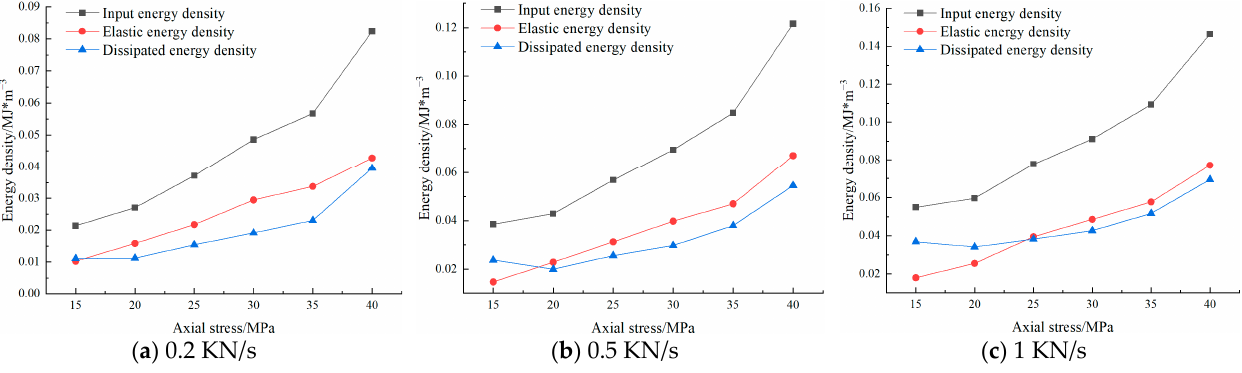
Figure 6. Rock energy evolution curve under different loading rates. Rocks exhibit different forms of damage at different loading rates. In essence, the different stress states determine how the rock energy is distributed and transformed. At the same time, the difference in energy state drives the different deformation and damage modes of the rock. It can be seen that the ratio of elastic energy and dissipative energy-to-input energy affects the damage mode of the rock. Figure 7 shows when the loading rate is 0.5 KN/s. The variation of elastic energy ratio and dissipation energy ratio with axial stress of the rock. From the figure, it can be seen that the elastic energy ratio and dissipation energy ratio vary nonlinearly with the axial stress. The elastic energy ratio increases at the beginning of loading, and then increases when the loading reaches about 48% of the peak stress; it reaches the maximum when the axial stress is loaded to about 73% of the peak stress. The dissipation energy ratio exceeds the elastic energy ratio at the early stage of loading. This shows that the closed friction of microcracks and dislocation between rock blocks dissipate a lot of energy in the compaction stage, thus resulting in the proportion of dissipated energy greater than the proportion of elastic energy. As the loading continues, the dissipated energy ratio gradually decreases. From the initial loading to the loading of about 73% of the peak stress, the dissipation energy ratio decreases by about 30%. After that, the dissipative energy ratio increases. With the continuous expansion of microcracks, the specimens are continuously damaged, and the microcracks are connected from random and disorderly sprouting to orderly nucleation, thus forming macroscopic cracks and destabilizing extension. The ability of the rock to store elastic energy decreases, percentage of elastic energy decreases, and percentage of dissipated energy increases. This can be used as a precursor to destabilization damage in rock specimens.